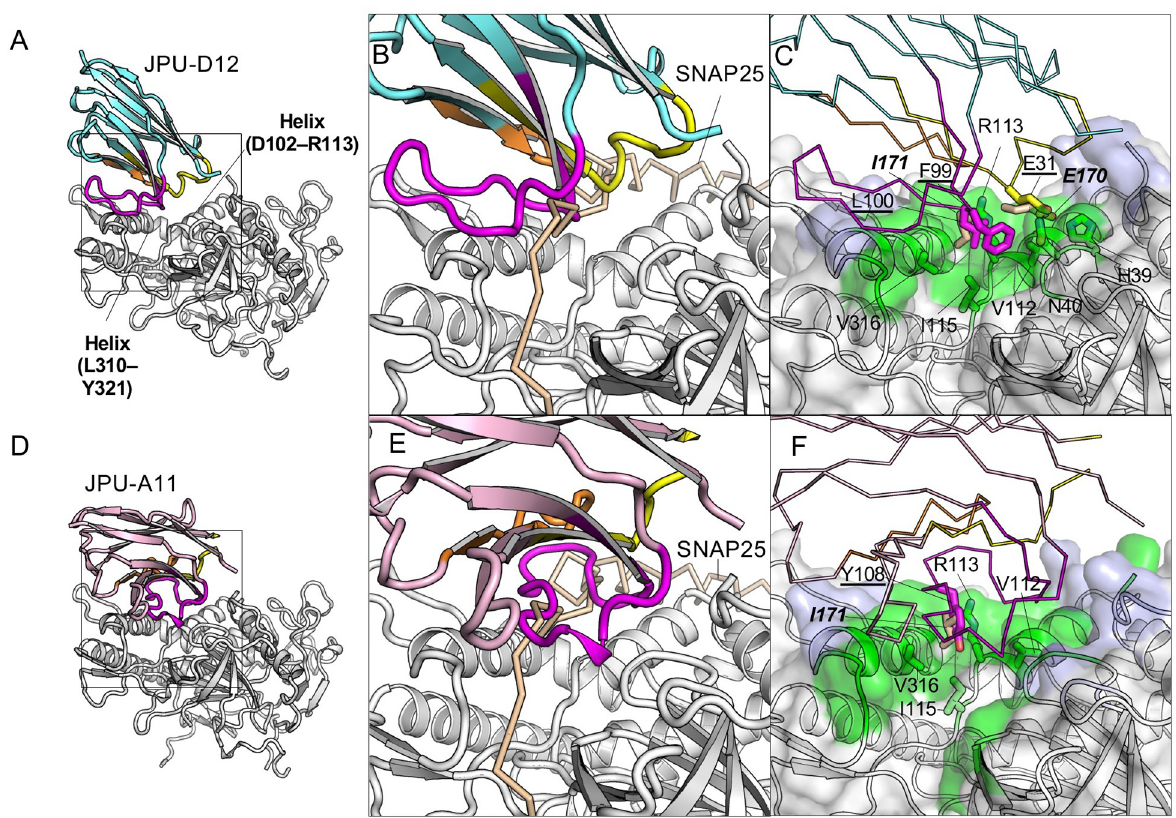
Fig 4. JPU-D12 and JPU-A11 block the interaction of SNAP25 to the anchoring site I of LC/A. (A, D) Cartoon representation of JPU-D12 (A) or JPU-A11 (D) in complex with LC/A. The framework region of JPU-D12 and JPU-A11 are colored cyan and pink respectively. The CDR1, 2, and 3 are colored yellow, orange, and magenta, respectively. (B, E,) Superimposition of LC/A–JPU-C1 (B) or LC/A–JPU-G3 (E) with the SNAP25(146– 204)-bound LC/A (PDB ID: 1XTG). Only the VHH-bound LC/A is represented. LC/A and SNAP25 are colored as that shown in Fig 3. (C, F) The VHH residues competing with SNAP25 residues for LC/A binding are drawn as sticks. The epitopes are colored as that shown in Fig 2.